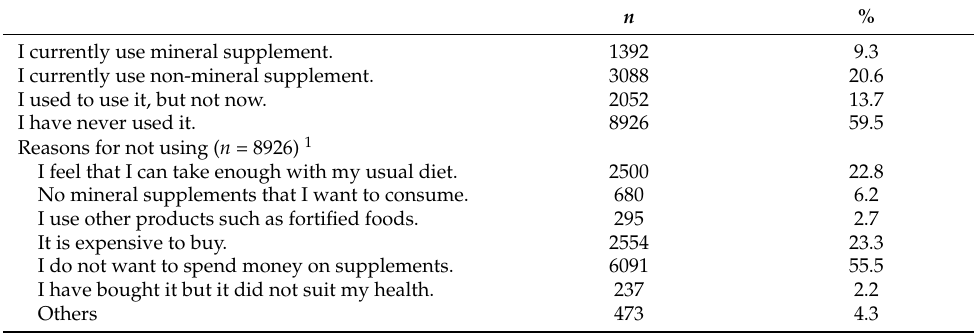
Table 4. The prevalence of mineral supplement usage and reasons for